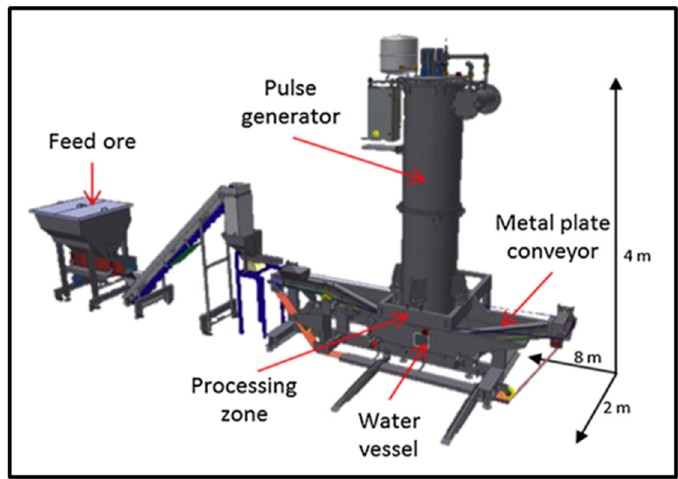
Figure 11. High voltage pulse pilot scale testing machine at Kerzers, Switzerland (reproduced with permission) [100].